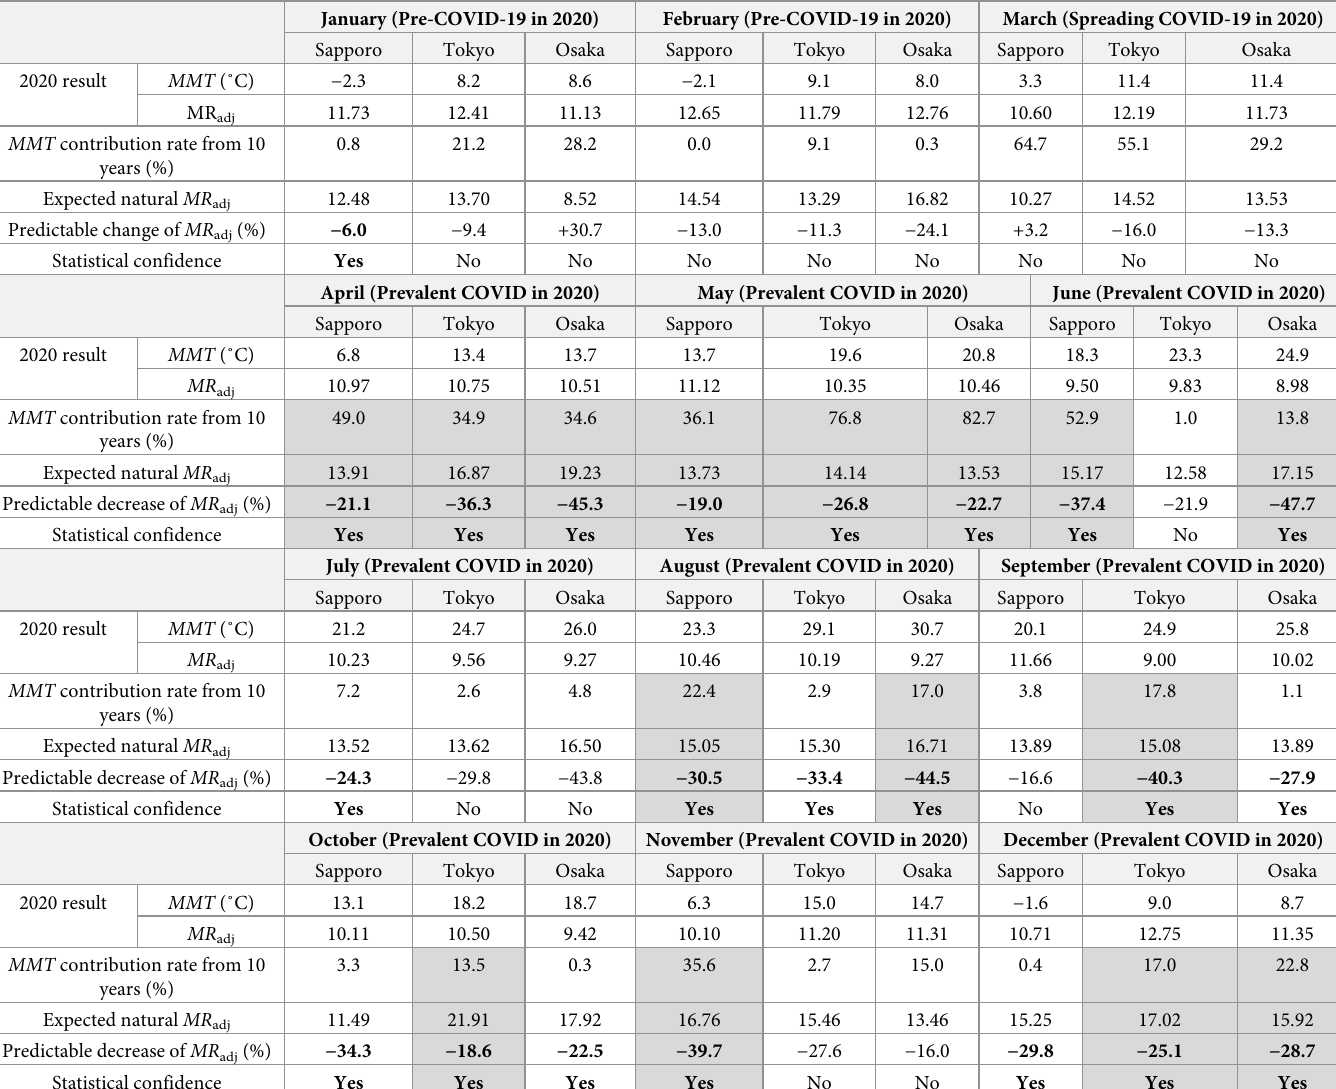
Table 3. Predictable changes in MR adj for cerebral infarction (CI) estimated in this